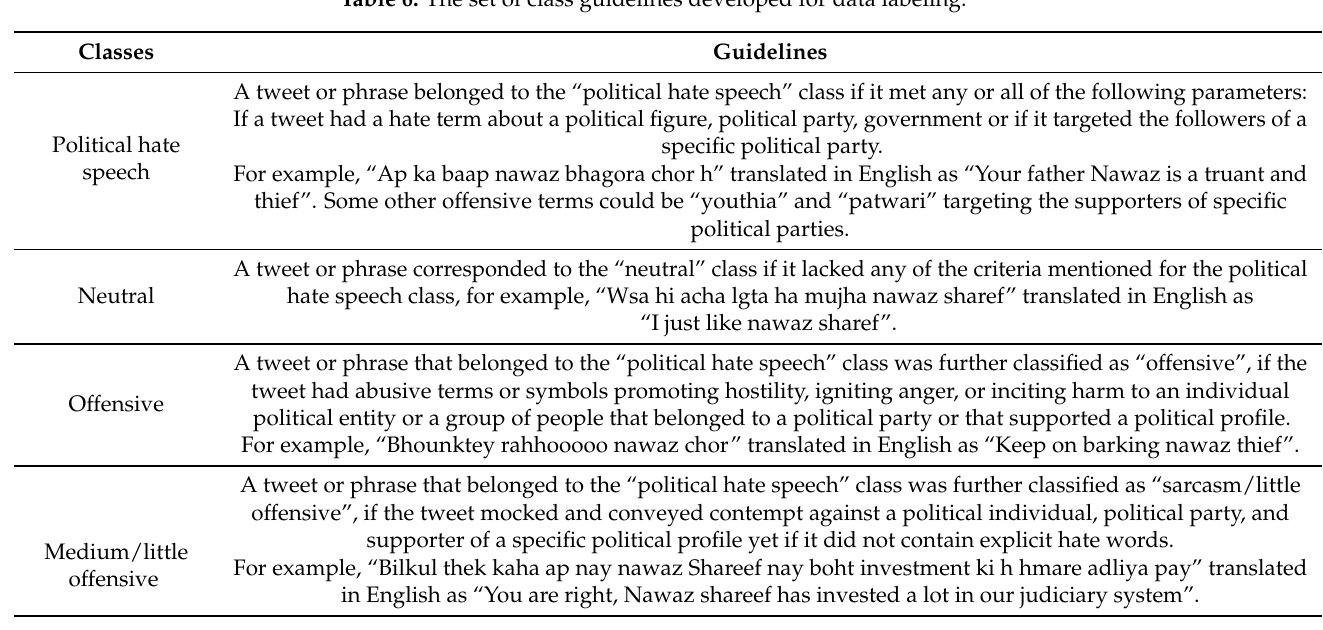
Table 6. The set of class guidelines developed for data labeling.